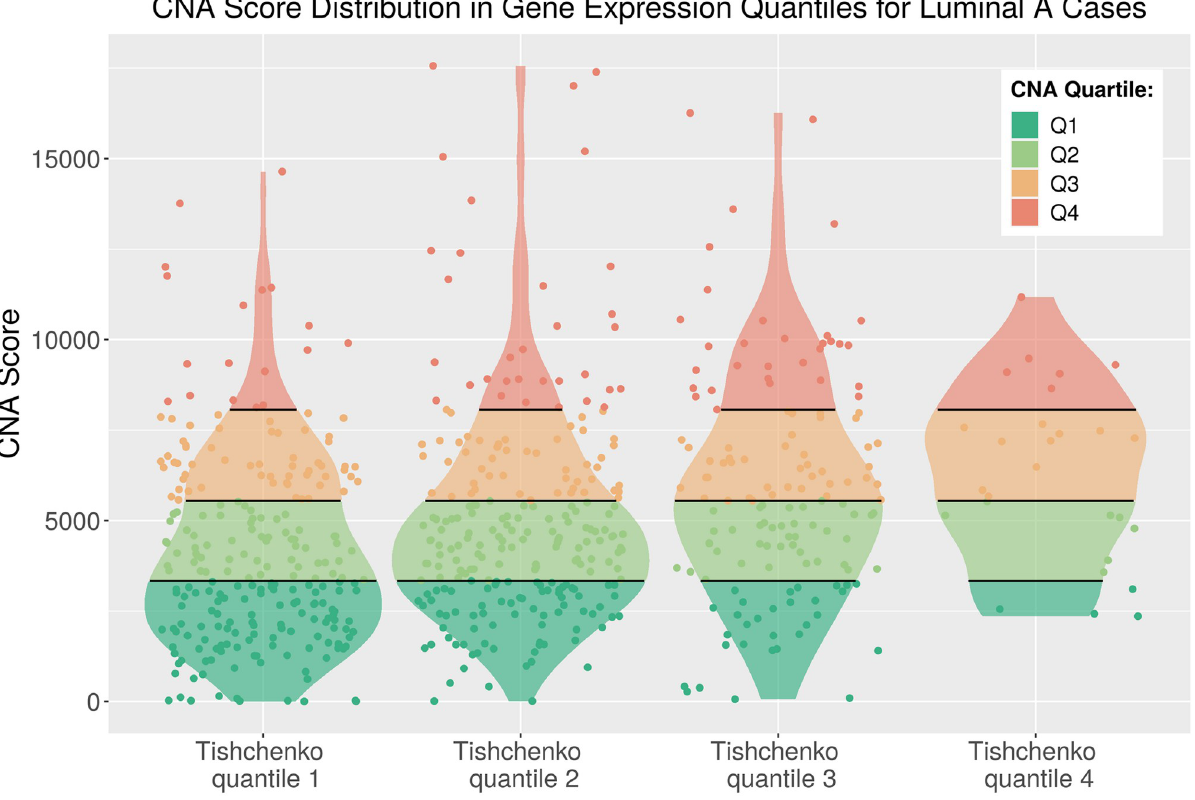
Fig 6. CNA Score distribution in gene expression quantiles of Tishchenko et al [13] for ordinary luminal A cases. CNA Quartile thresholds from Fig 1 indicated across violin area. Outliers were removed.